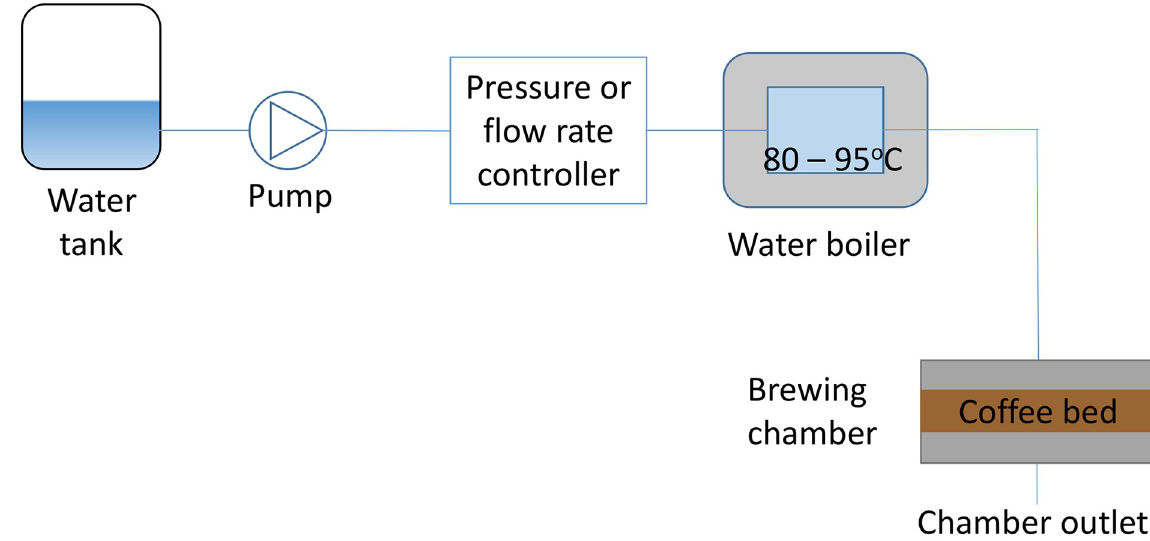
Fig 2. Experimental set-up. Schematic of the experimental set-up.